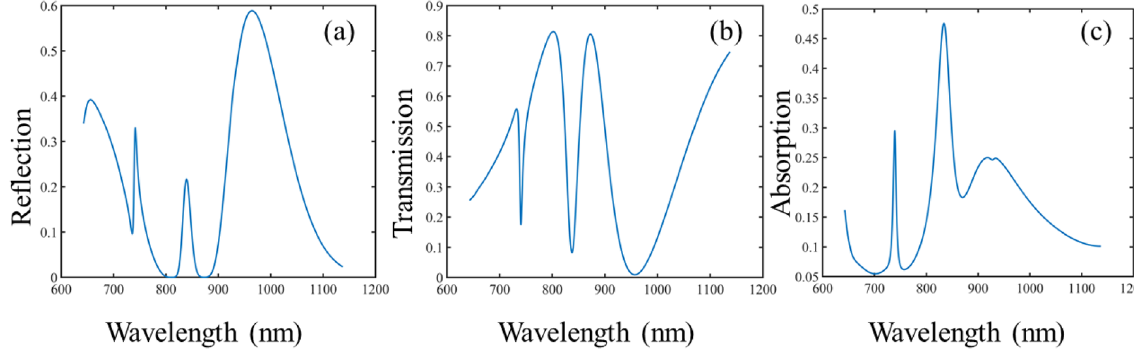
Fig. 3. Spectra of the MIG metasurface with geometry arrangements matching the rhodamine 6G Raman shift D 1 =1314 cm − 1 : (a) re fl ection, (b) transmission and (c) absorption. Table 1. Geometry parameters ( d , g ) for which the spectral response of the investigated metasurface adjusts to different rhodamine 6G Raman shifts D j ; resonance positions of the resulting peaks in the metasurface spectral response l j maximum value of the corresponding local scattered fi eld enhancement factors at peak wavelengths Þ ≡ FE ð ~ r ; l j Þ , and the maximum value of the local SECARS enhancement factor G D j FE ð l j m ax s ; p ; a s ; p ; a is here performed over positions within the unit cell. Geometry